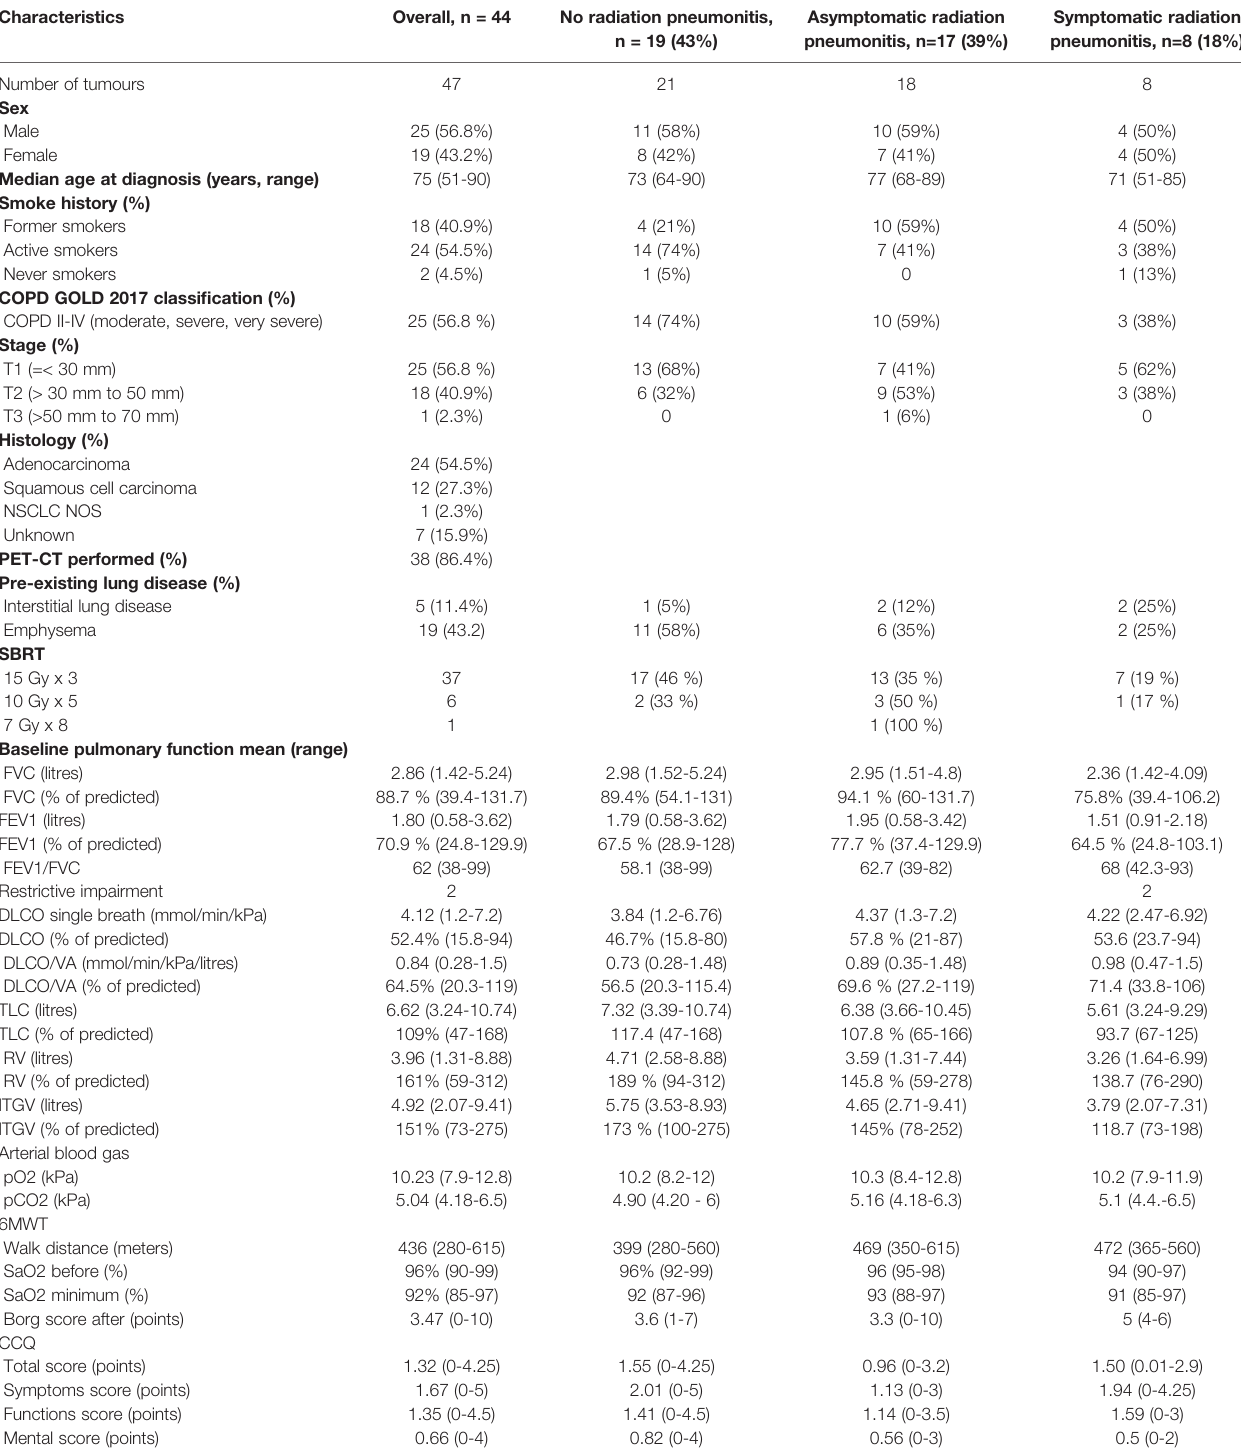
TABLE 1 | Baseline characteristics before stereotactic body radiotherapy (SBRT).